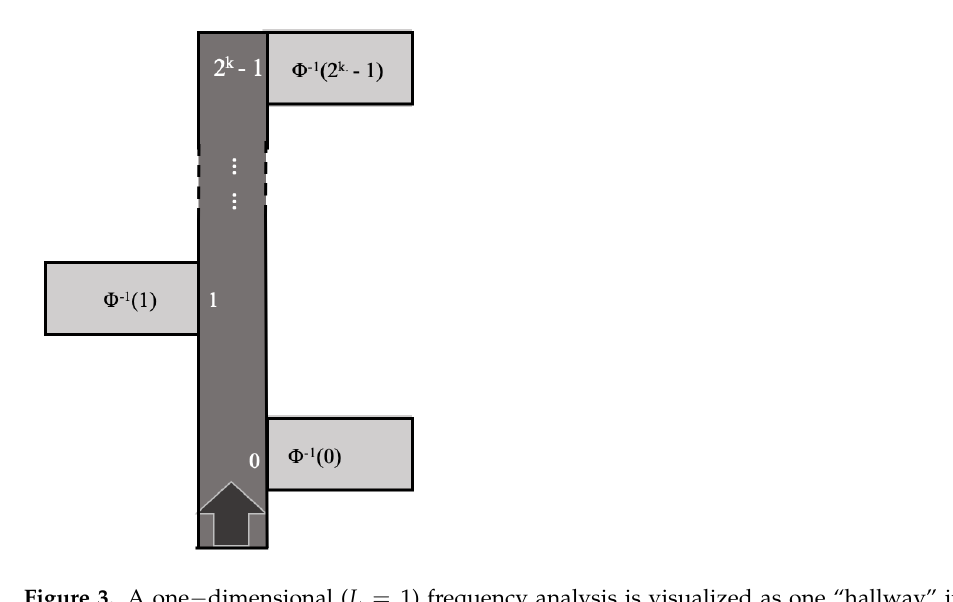
Figure 3. A one − dimensional ( L = 1) frequency analysis is visualized as one “hallway” in the corner-turning